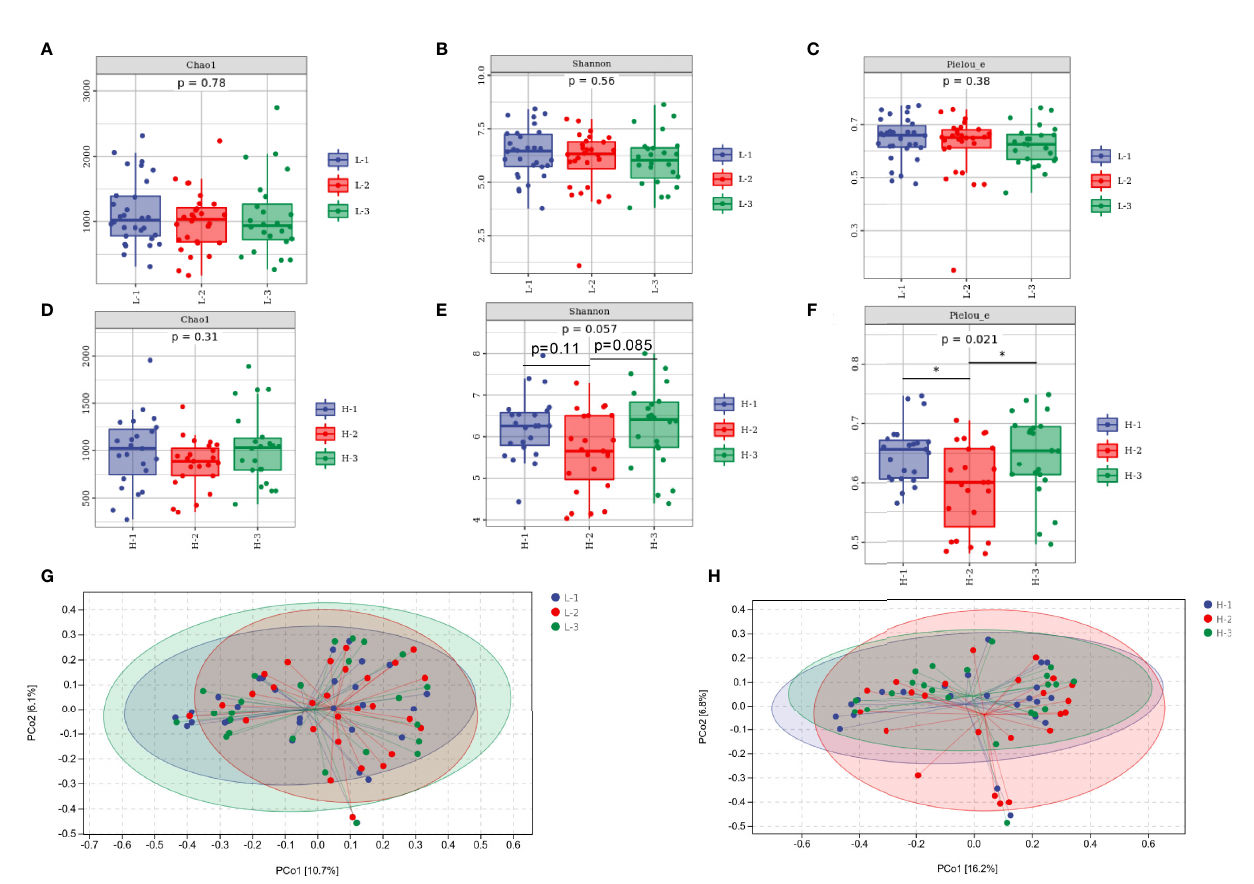
FIGURE 4 | The diversity of the gut microbiota between the L-VA and H-VA therapy groups. Bacterial alpha diversity estimated by Chao1 (A) , Shannon (B) , and Pielou indices (C) at the three time points of L-VA therapy. The Chao1 (D) , Shannon (E) , and Pielou indices (F) at the three time points of H-VA therapy. Bacterial beta diversity estimated by PCoA at three time points of L-VA (G) and H-VA (H) therapy. L-VA: dual therapy consisting of a low dose of amoxicillin (1000 mg b.i.d.) and VPZ (20 mg b.i.d.); H-VA: dual therapy consisting of a high dose of amoxicillin (1000 mg t.i.d.) and VPZ (20 mg b.i.d.); L-1: the time point before eradication in the L-VA group; L-2: the time point after eradication in the L-VA group; L-3: the time point of con fi rmation in the L-VA group; H-1: the time point before eradication in the H-VA group; H-2: the time point after eradication in the H-VA group; H-3: the time point of con fi rmation in the H-VA group; * P